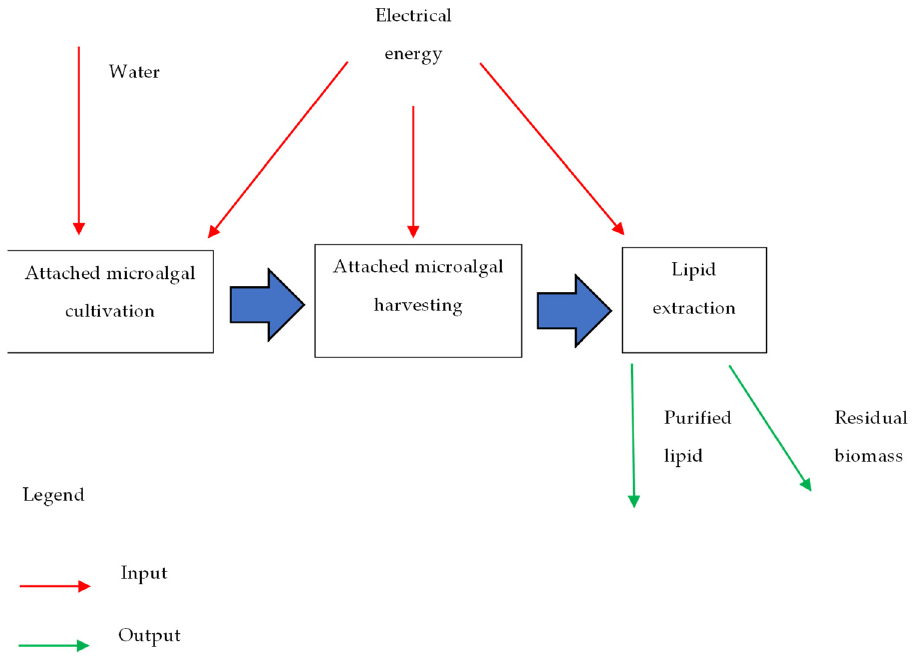
Figure 5. Process flow diagram for microalgal lipid production from attached microalgal growth on a palm decanter cake substrate.